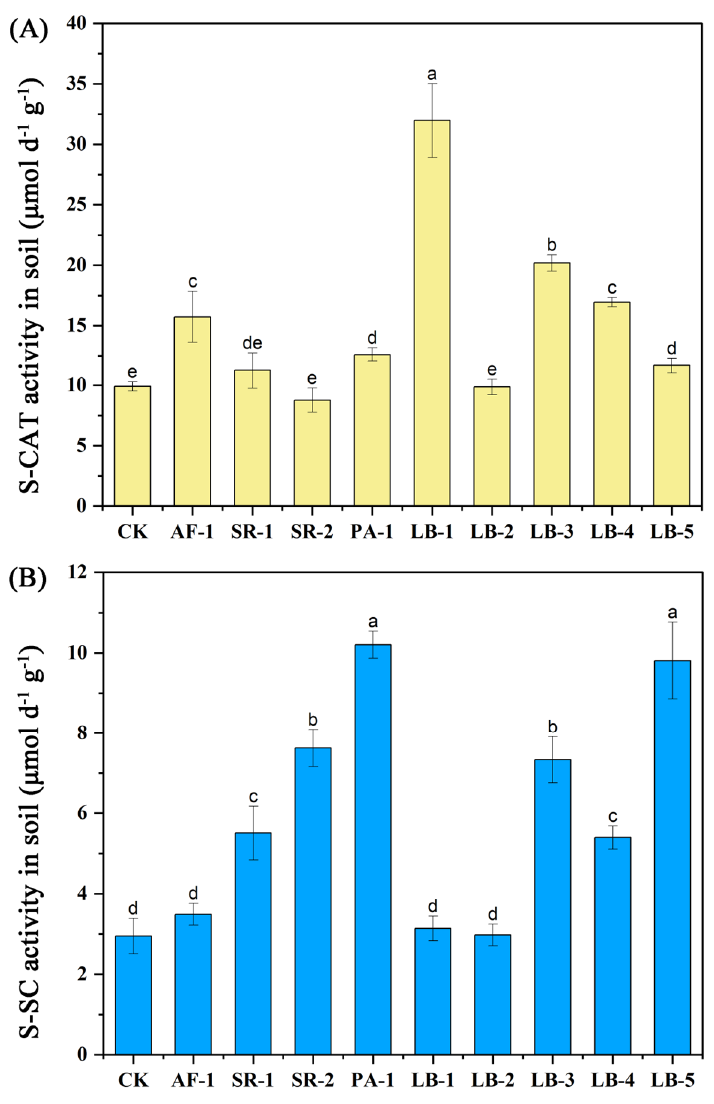
Figure 1. S-CAT and S-SC activity in the rhizosphere soil of different treatments. ( A ): S-CAT activity in soil. ( B ) S-SC activity in soil. The same le(cid:308)er means no significant difference.